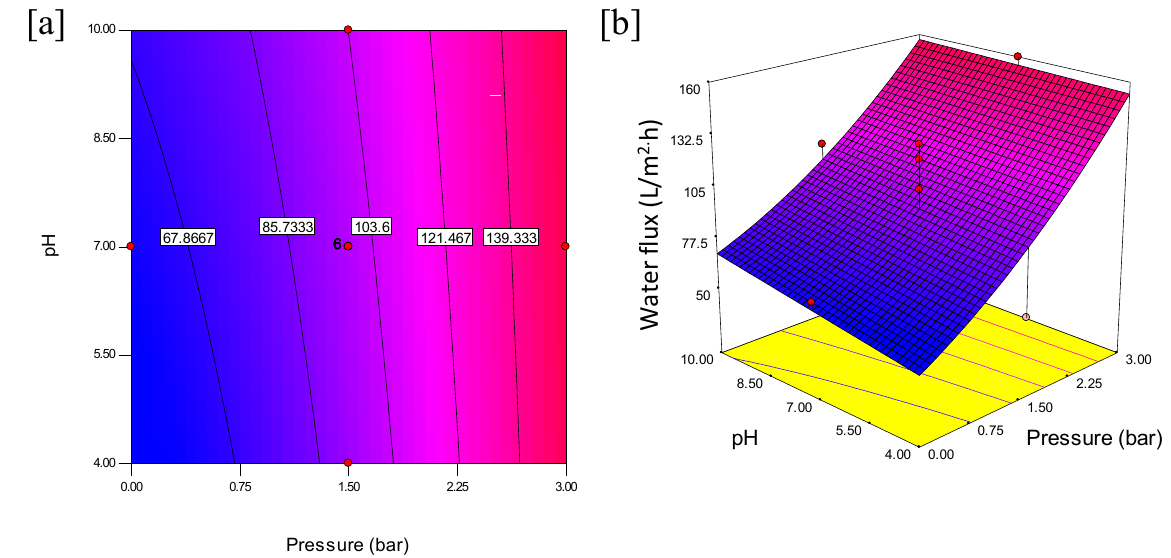
Figure 8. Contour plot ( a ) and 3D surface graph ( b ) for the interaction effect of pressure and pH on water flux (L/m 2 ·h).